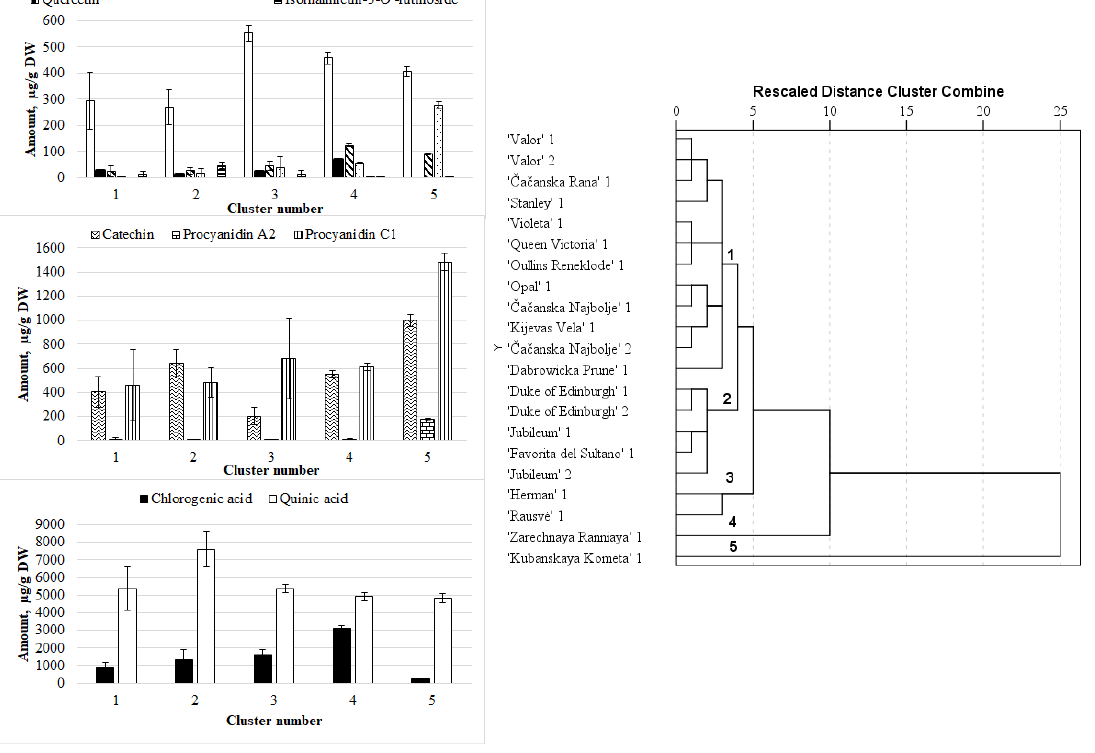
Figure 1. The dendrogram of hierarchical cluster analysis (HCA) of plum fruit samples based on the phytochemical composition and mean values of contents of the identified compounds (µg/g DW) of the plum cultivar fruit groups extracted using HCA. 1—“Myrobalan” ( P. cerasifera Ehrh.) rootstock; 2—“Wangenheim Prune” ( P. domestica L.) rootstock.